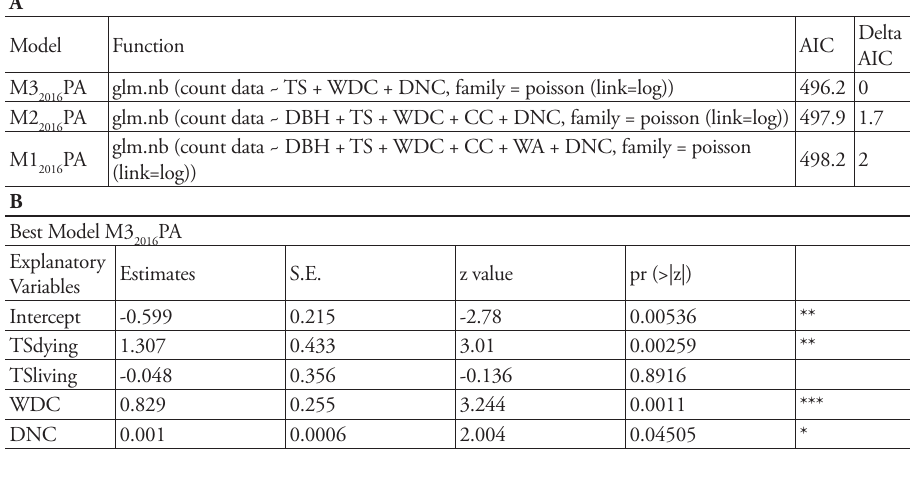
Table 7. Generalised Linear Models results. A) Explanatory variables selection and final best model for count data for R. alpina PA in 2016. For each model are reported the function used to build the model, AIC value and Delta AIC for selecting the best model, B) Estimates and standard error (S.E.) of the three